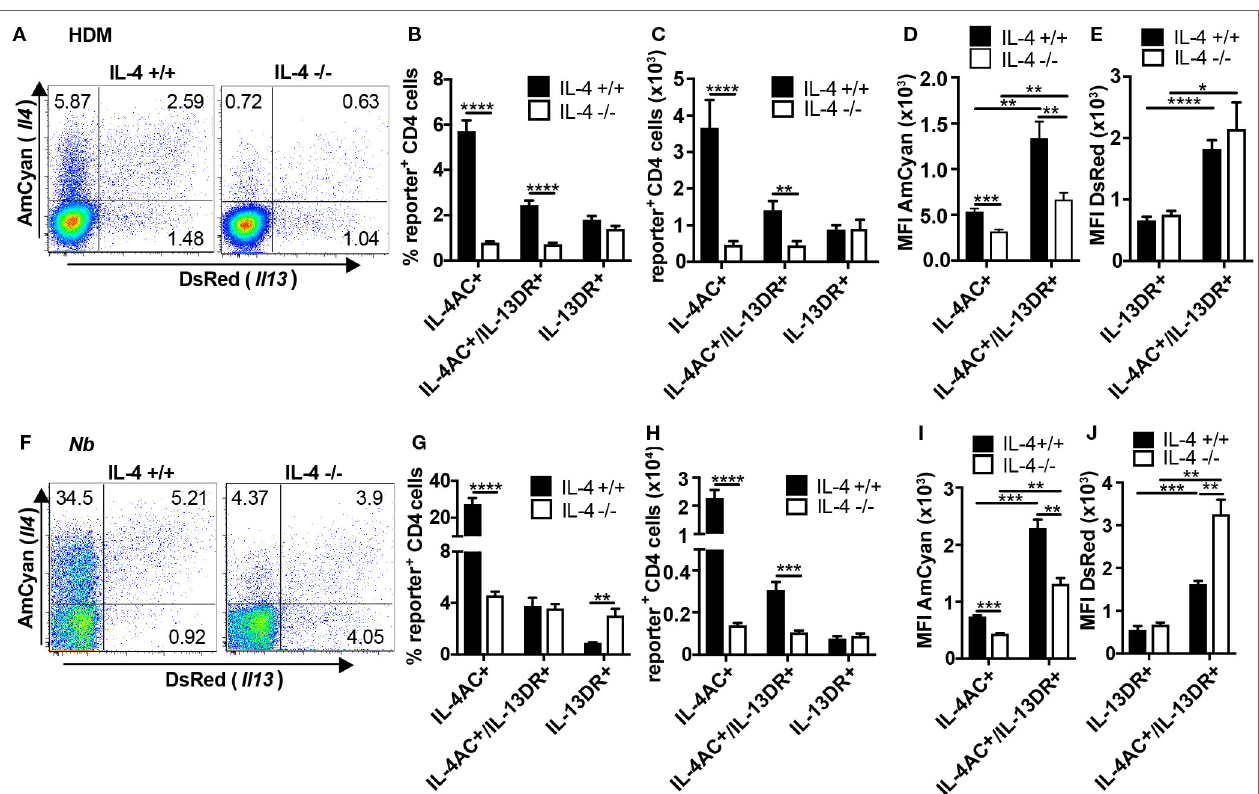
FigUre 4 | IL-4 is required for the development of IL-4AC- and IL-4AC/IL-13DR-expressing Th2 subsets but not the IL-13DR-expressing CD4 + T cell subset in ear tissue. 4C13R-IL-4 + / + and 4C13R-IL-4 − / − mice were treated with either (a–e) 200 μ g house dust mite (HDM) or (F–J) 600 dead L3 Nippostrongylus braziliensis ( Nb ) i.d. in the ear pinnae. Ear tissue was harvested 7 days posttreatment. Tissues were analyzed to determine (a,B,F,g) proportion of IL-4AC + and IL-13DR + CD4 T cells, (c,h) number of IL-4AC + and IL-13DR + CD4 T cells, and (D,e,i,J) median fluorescent intensity (MFI) of IL-4AC and IL-13DR for each of the Th2 cell subsets. Data representative of seven experiments ( n = 35–37) for HDM and two experiments ( n = 6) for dead Nb . (a) FACS plots concatenated from a single representative experiment ( n = 6). (B,c) Data pooled from seven experiments ( n = 37). (D,e) Data from a single representative experiment ( n = 6). (F) FACS plots concatenated from a single representative experiment ( n = 3). (g,h) Data pooled from two experiments ( n = 6). (i,J) Data from a single representative experiment ( n = 3). Data